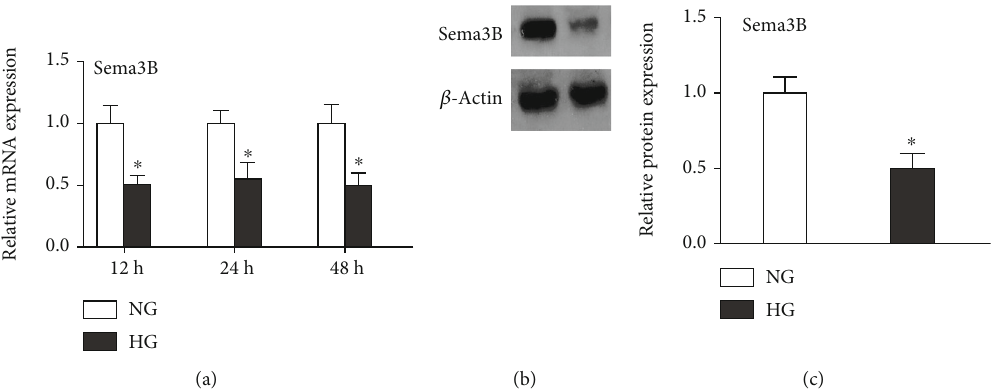
Figure 2: E ff ects of HG onSema3B expression. Sema3B expression levels were measured by real-time PCR and western blotting. (a) HG treatment suppressed Sema3B mRNA expression in BMSCs at 24, 48, and 72 h. (b) Representative western blots. (c) HG decreased Sema3B protein expression in BMSCs. Data are expressed as the mean ± SEM ( n = 3 ). ∗ P < 0 : 05 compared to the control sample.